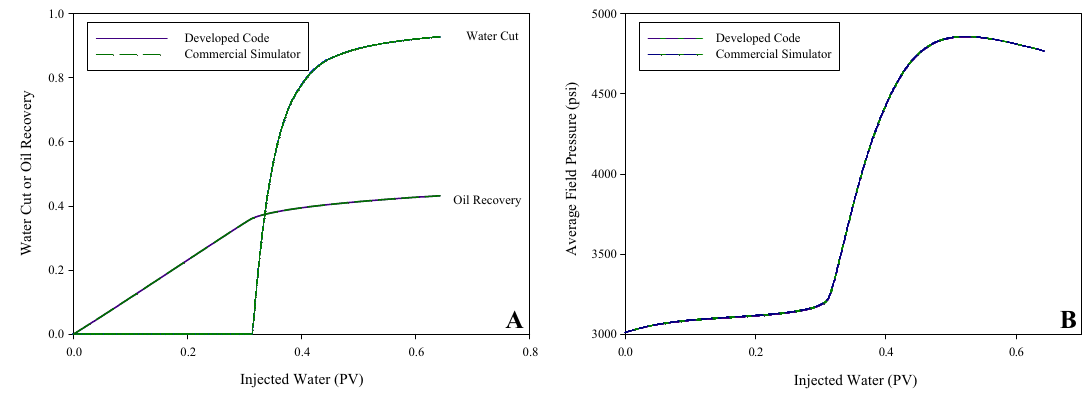
Fig. 4 a Comparison of the field oil recovery and well water cut, and b comparison of average field pressure values between the developed code and the commercial simulator Table 2 Statistic parameters for comparing the result of base case obtained by developed core and commercial simulator